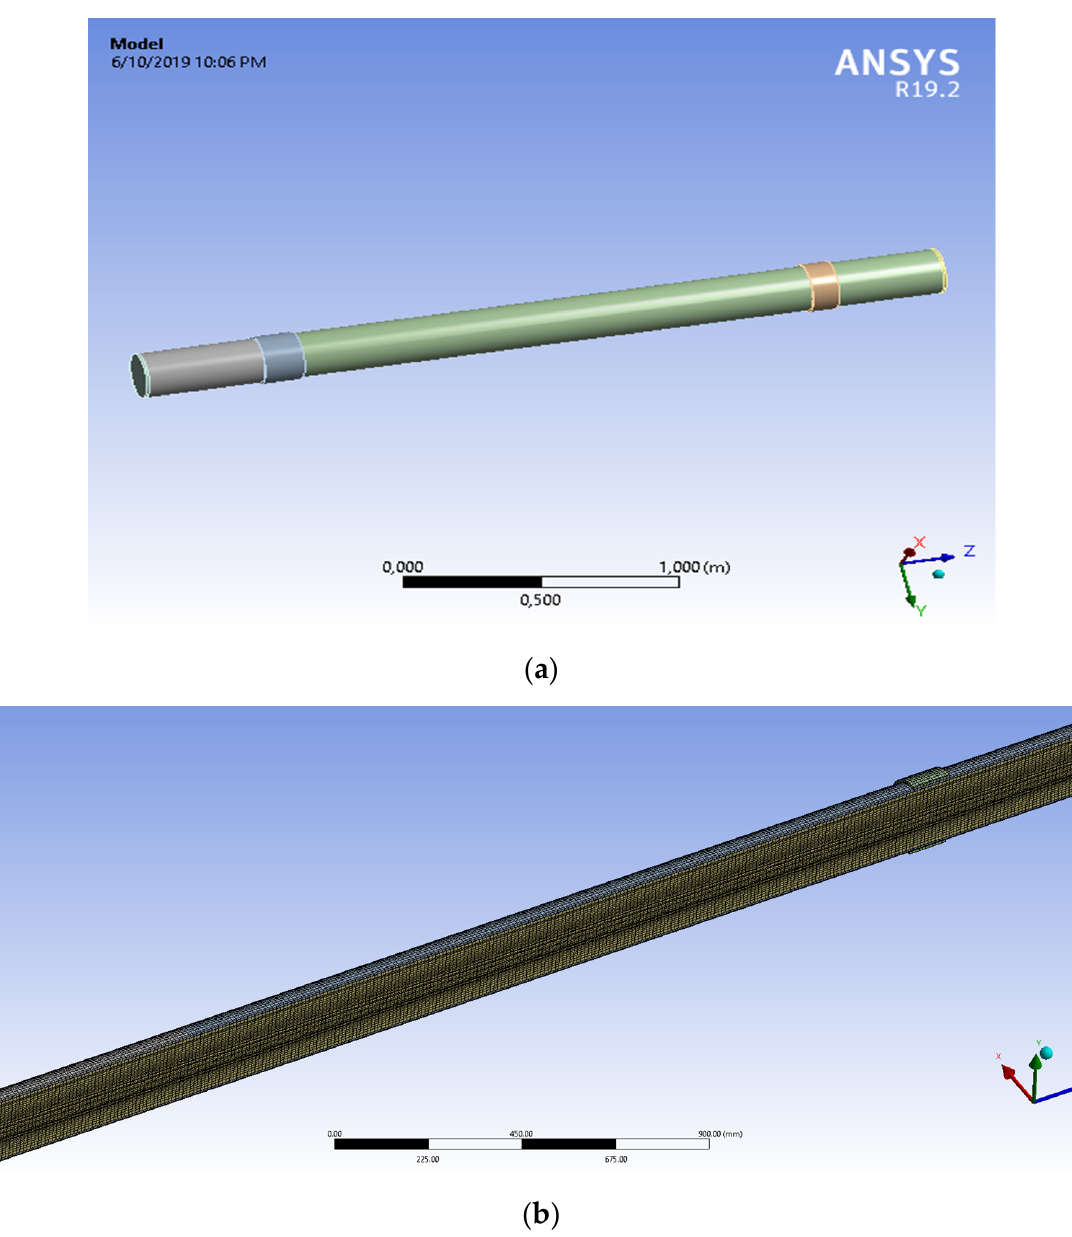
Figure 7. The flexible assembly of GRP pipe ( a ) geometric model ( b ) mesh view. The geometry of the model was made in spaceclaim 2019 version. For the geometry of the model each dimension was written according to the experimental study. The layers of the pipe were modelled one by one, and the contact area between each layer was set to bonded type, all the materials characteristics are presented in Table 3. The structural analysis was made in static structural model of ANSYS statical 2019 coupled with Fluent resulting a fluid-structured analysis (FSI) Figure 8. From the Fluent model is resulted the pressure given by the water to the pipe walls. In Fluent the viscous model was set to k-epsilon, also the solver was set to a pressure-based type Tables 3 and 4. The analysis was made in steady state time. The solution method scheme was coupled as the pressure was completed by a static action in static structural